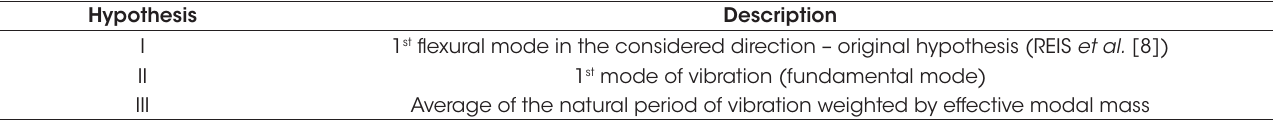
Summary of each hypothesis for the natural period of vibration selection Hypothesis Description